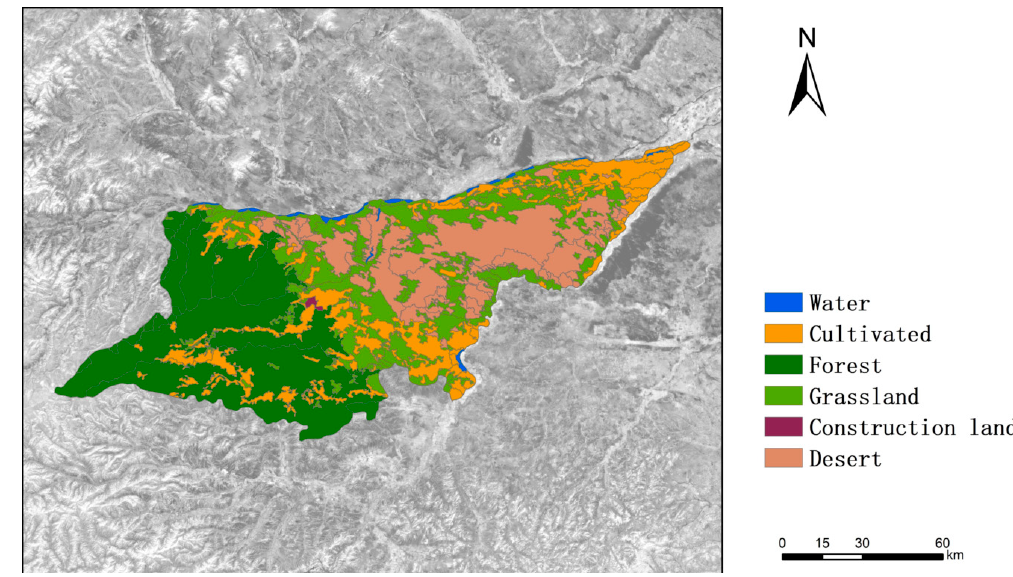
Figure 8. Distribution of the minimum response unit.